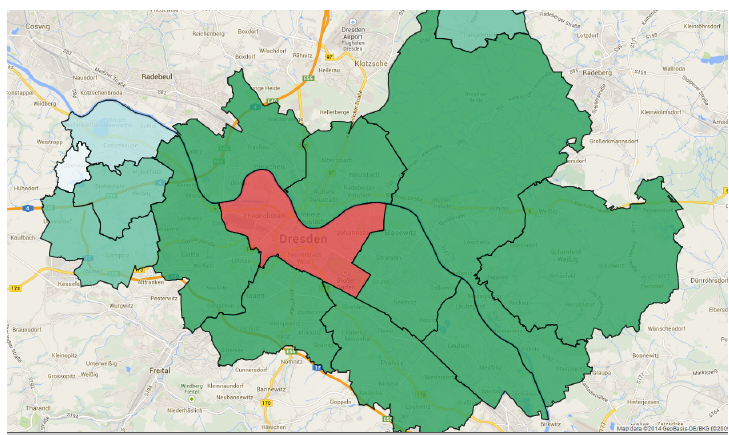
Figure 2 . Querying the conventional map boundaries.